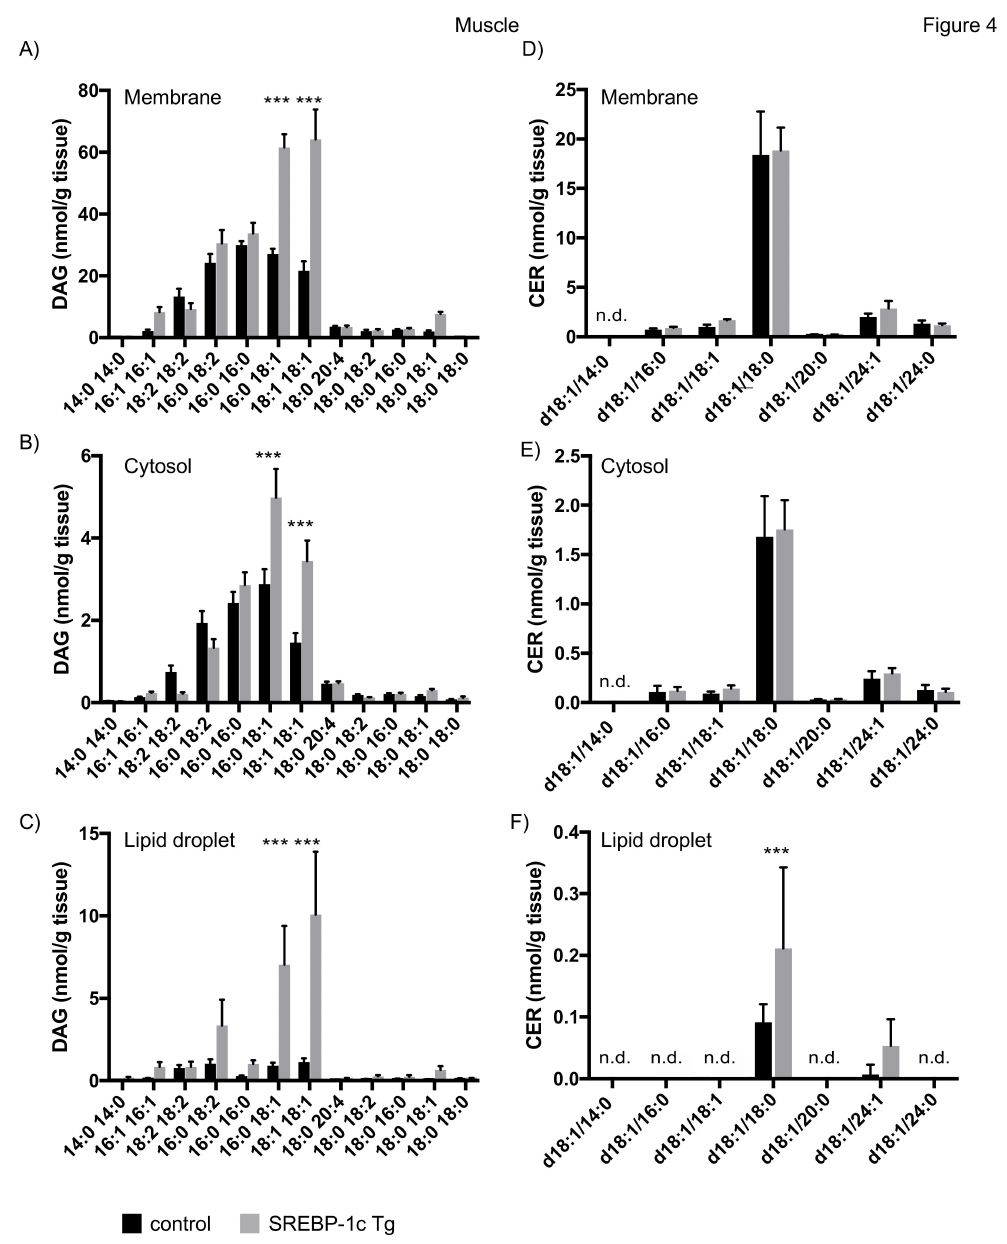
Figure 4. Mass spectrometry analysis of DAGs and CERs in skeletal muscle tissue fractions. Muscle tissue of SREBP-1c adipose-specific overexpressing transgenic (Tg) mice (SREBP-1c Tg) and control mice was subjected to subcellular fractionation. The indicated DAG species were analysed by LC-MS/MS in membrane ( A ), cytosolic ( B ) and lipid droplet fraction ( C ). The indicated CER species were analysed in membrane ( D ), cytosolic ( E ) and LD fraction ( F ). All data are presented as mean ± SEM (n = 6 per group). n.d., not detected; *** p < 0.001; 2-way ANOVA with Bonferroni